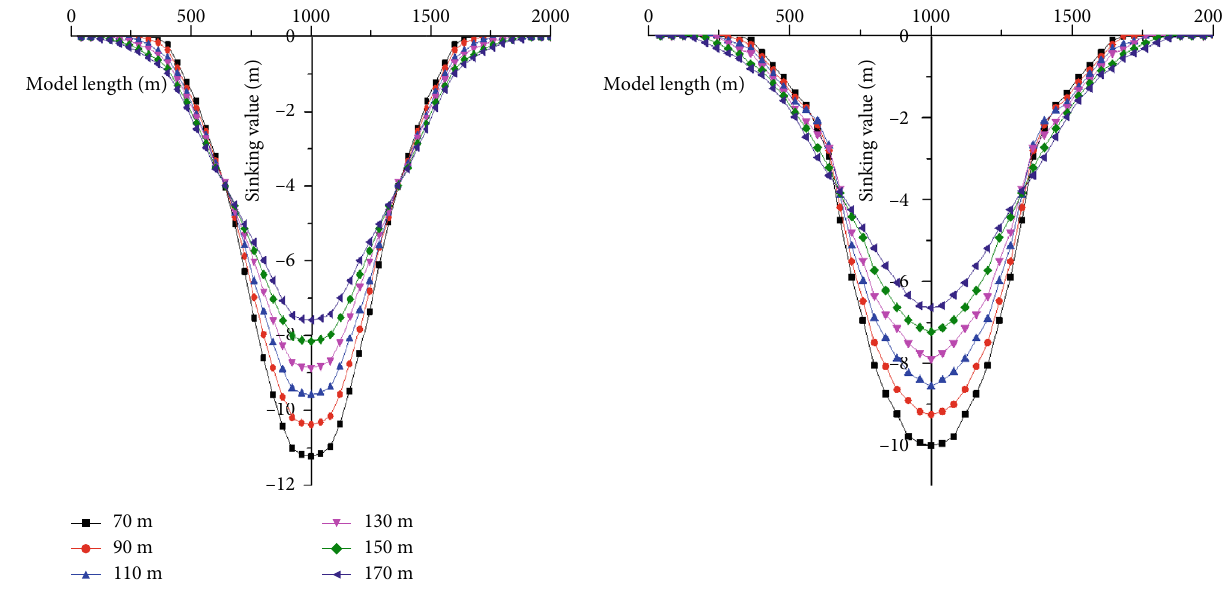
Figure 10: Surface sinking curve with di ff erent transitional font thickness.